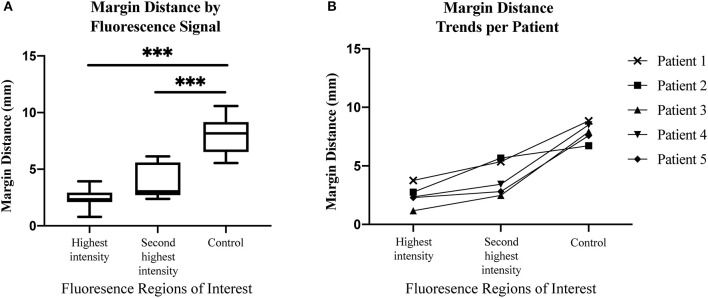
(A) Box and whisker plots demonstrating margin distance by fluorescent signal. (B) Graph demonstrating margin distance trends from region of highest fluorescence intensity to second highest fluorescence intensity, to control region per patient. ***p < 0.0001.